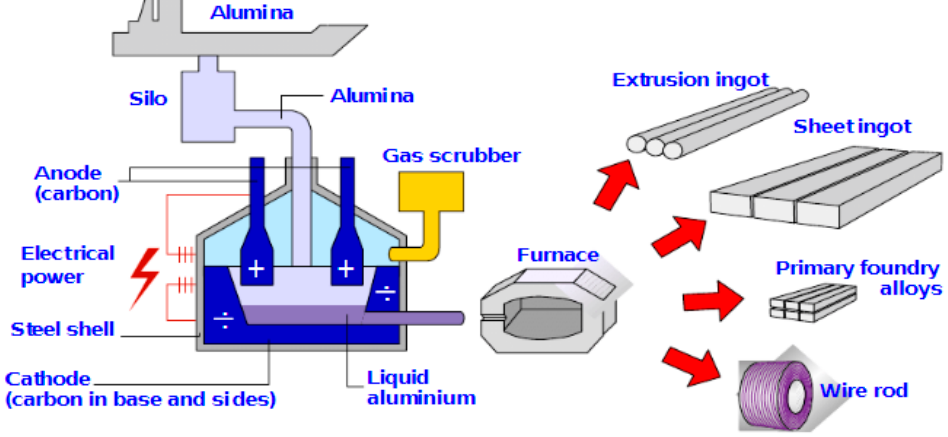
Figure 11. Scheme of aluminium production cell.